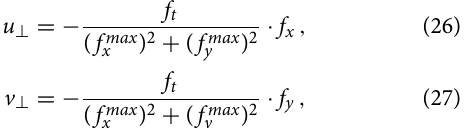
FIGURE 7 | Filter F in x – t –space (left, center; c.f. DeAngelis et al. (1995), Their Figure 3F) and in Fourier domain (right; absolute value) for σ = 25 , f 0 x = f 0 y ≈ 0 . 057 ( f 0 = ( f 0 x ) 2 + ( f 0 y ) 2 = 0 . 08 ) and µ bi 1 = 0 . 2 (as in Figure 4). Red line q